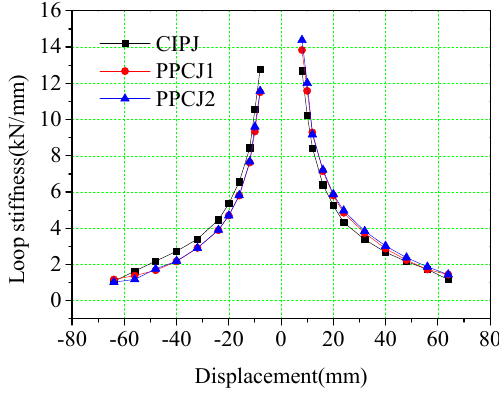
Figure 19. Relationship between loop stiffness and displacement of the joint right beam.